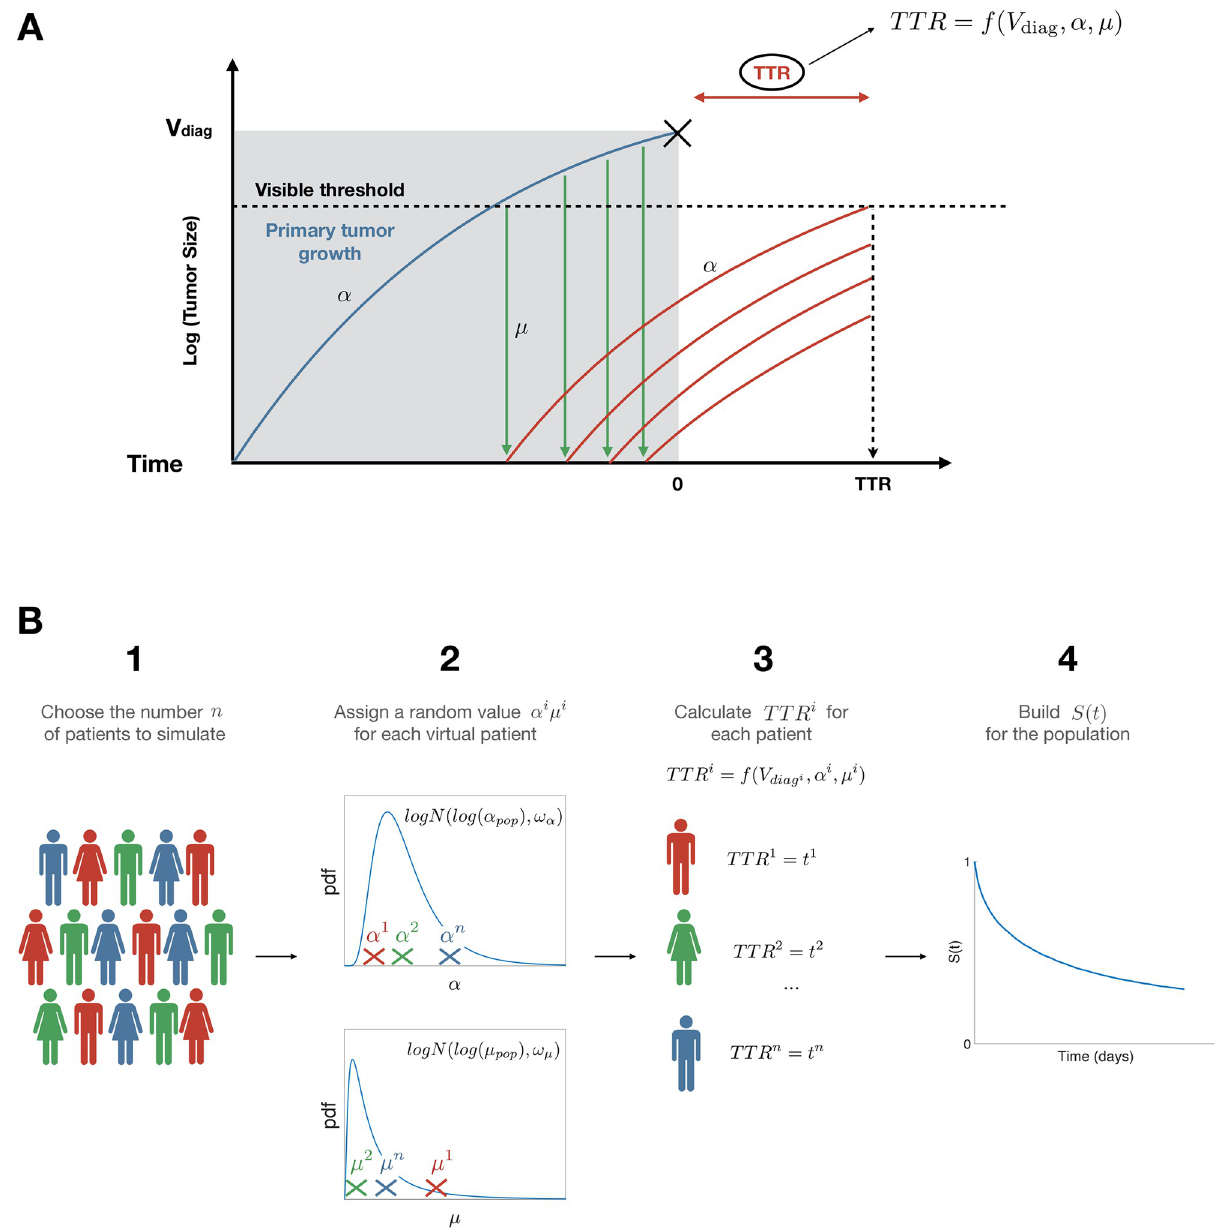
Fig 1. Scheme of the mechanistic model. A) Individual processes (adapted from [7]). Parameter α quantifies tumor growth while parameter μ quantifies metastatic dissemination. B) Population scheme, with S(t) the survival function of the random variable TTR . pdf = probability density